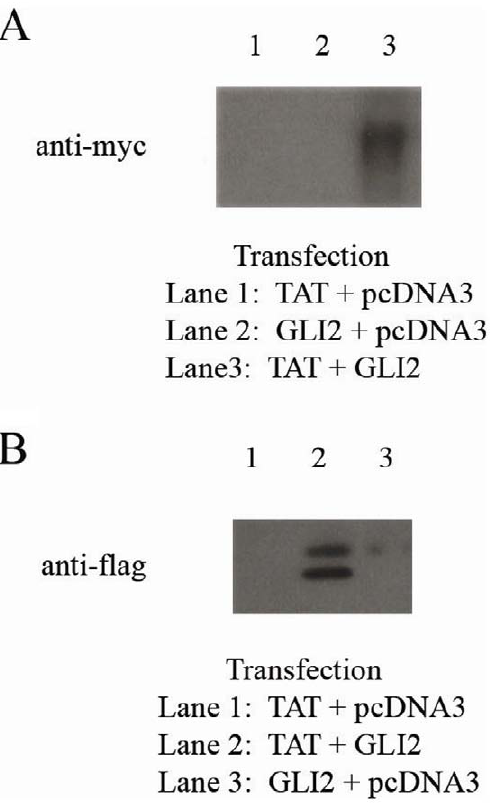
Figure 6. HIV-1 Tat Binds to Human GLI2. Co-immunoprecipitation was used to test the binding of HIV-1 Tat to human GLI2. Dual transfections were done in 293T cells (plasmid combinations shown on right) to express the Tat-FLAG and GLI2-6xMYC proteins (pcDNA3=empty control vector). ( A ) Beads were coated with anti- FLAG antibody and incubated with cell lysates from transfections # 1–3 shown on right-hand side. Following washing and elution steps, the bound protein was run on a SDS-PAGE gel followed by Western Blotting to assess GLI2 binding. Anti-myc antibody was used to confirm binding of GLI2 to Tat when Tat was bound to the bead. ( B ) Beads were coated with anti-myc antibody and incubated with cell lysates from transfections # 1–3 shown on right-hand side. Following washing and elution steps, the bound protein was run on a SDS-PAGE gel and Western Blotting was done to look for HIV-1 Tat binding. Bands developed at approximately 27 kDa. Anti-flag antibody was used to confirm binding of Tat to GLI2 when GLI2 was bound to the